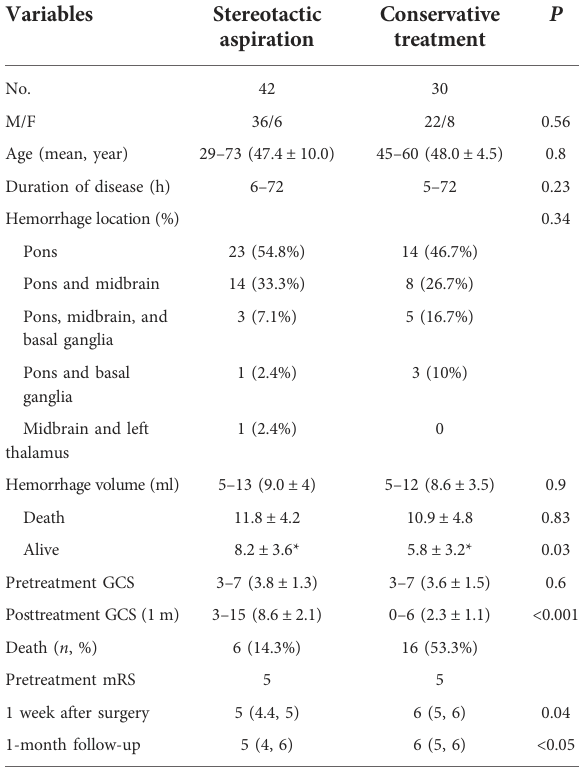
TABLE 1 Demography and treatment in the stereotactic aspiration and conservative groups.